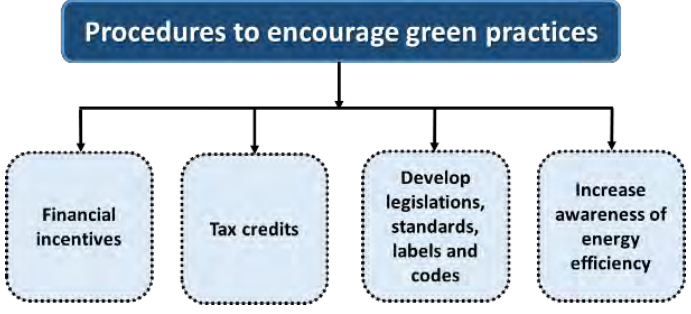
Figure 7. Incentives and procedures to encourage green